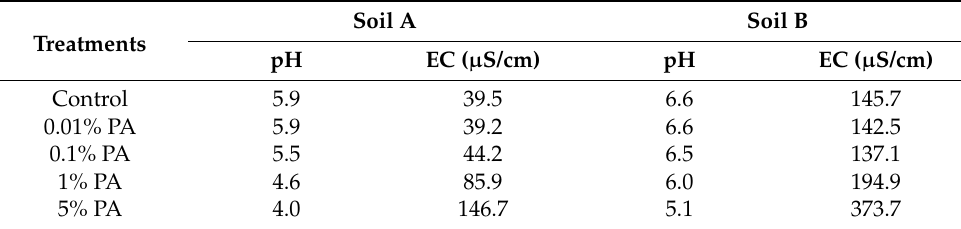
Table 1. Changes in soil pH and EC after spiking with different concentrations of PA.